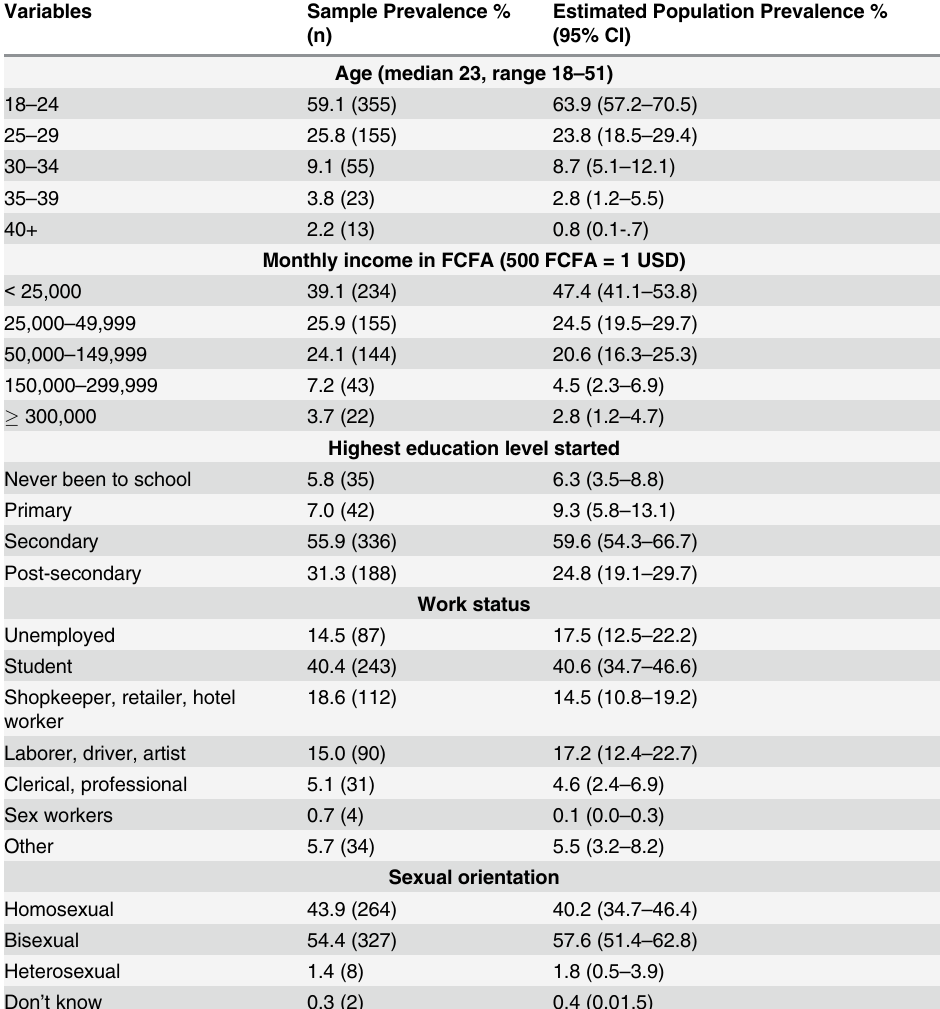
Table 1. Demographic and Social Characteristics of MSM in Abidjan, Côte d ’ Ivoire, 2011 – 2012 (n =